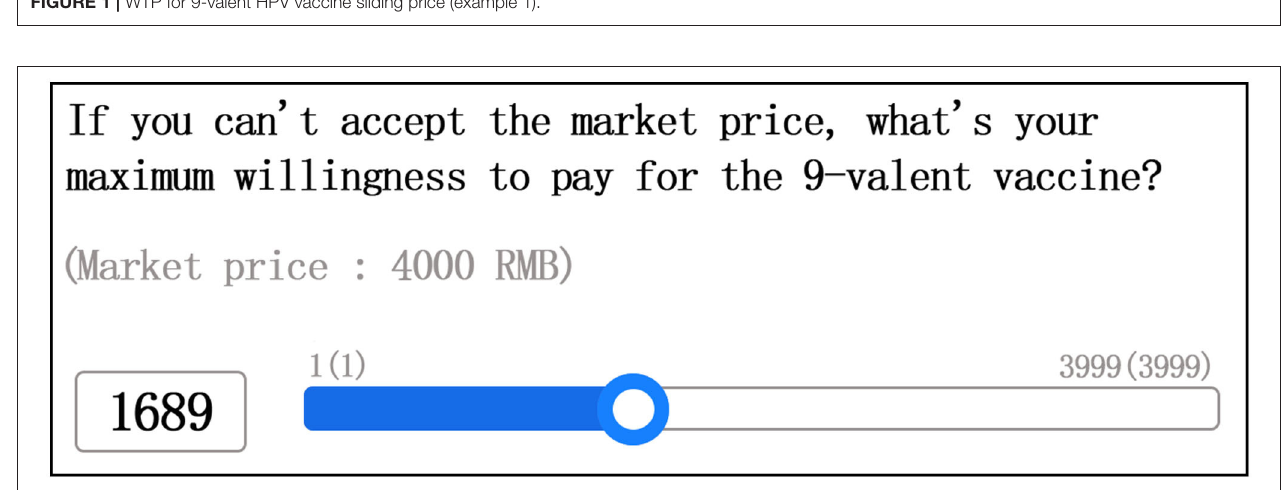
FIGURE 1 | WTP for 9-valent HPV vaccine sliding price (example 1).